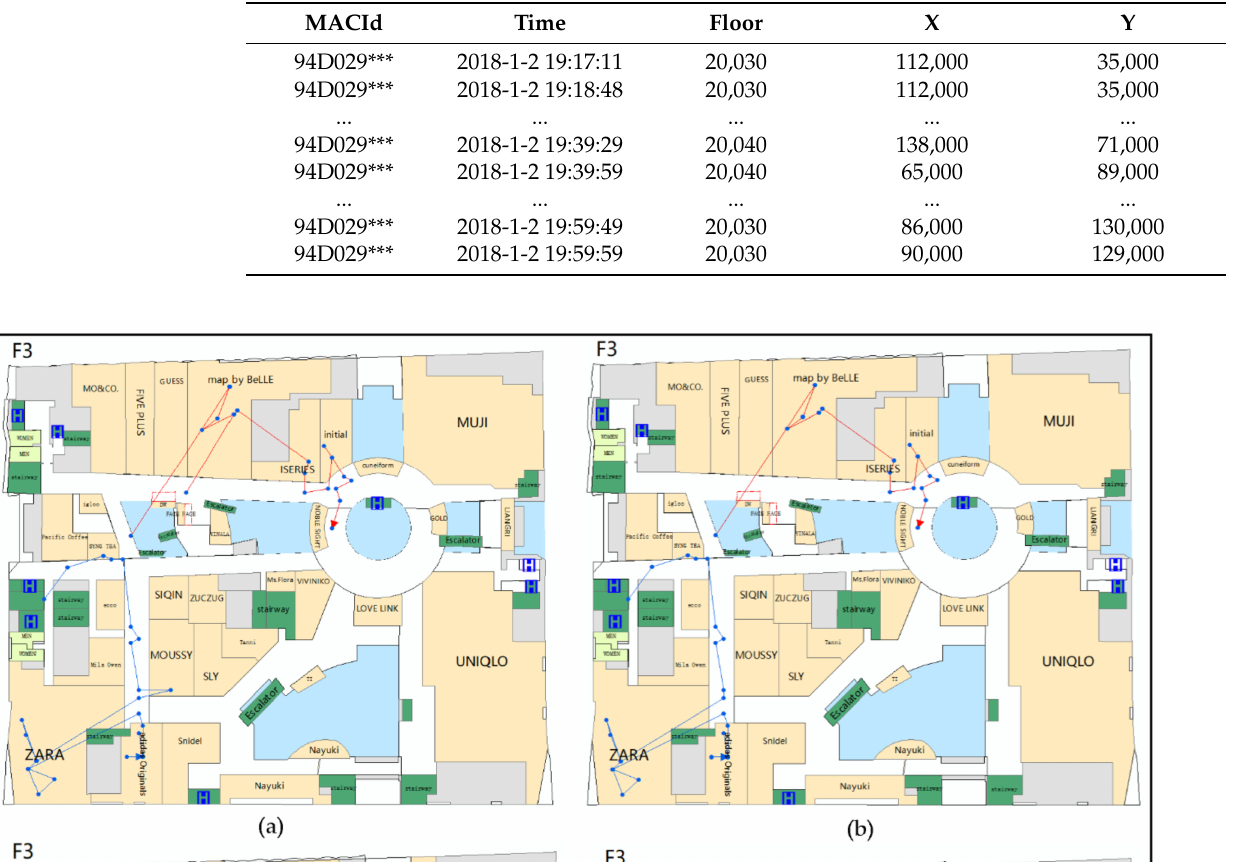
Table 3. Sample of raw trajectory.